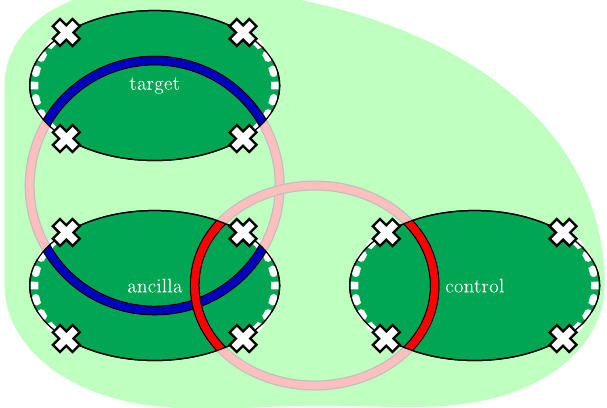
FIG. 15. Using the picture of twists, we can view lattice surgery as a measurement-only approach to performing logical gates between non-Abelian point particles. In bold colors, we show ¯ Z ¯ Z ¯ X ¯ X three planar codes, and the C A and A T measurements we need to perform lattice surgery are shown in red and blue, respectively. We also show with pale colors the qubits used in the measurement-only scheme above that are not required in the lattice surgery scheme. From this perspective, we see that lattice surgery is a measurement-only topological quantum computation scheme with a significant reduction in resource costs, as we are able to perform the required parity measurements with only O ð L Þ ancillary physical qubits, which is in contrast to O ð L 2 Þ qubits if we maintain all of the twist defects on the same